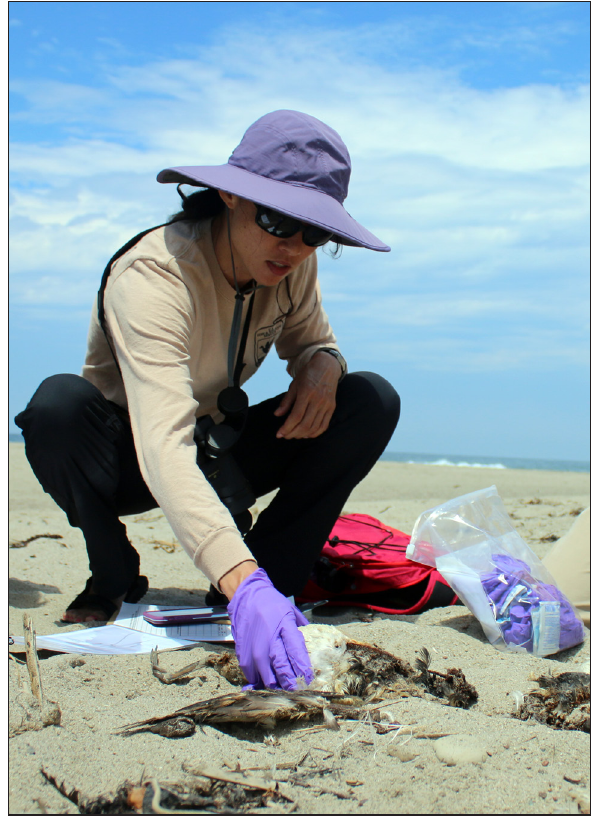
Figure 1: Participants in citizen science engage in a large number of activities such as designing studies, collecting and analyzing data, and disseminating project